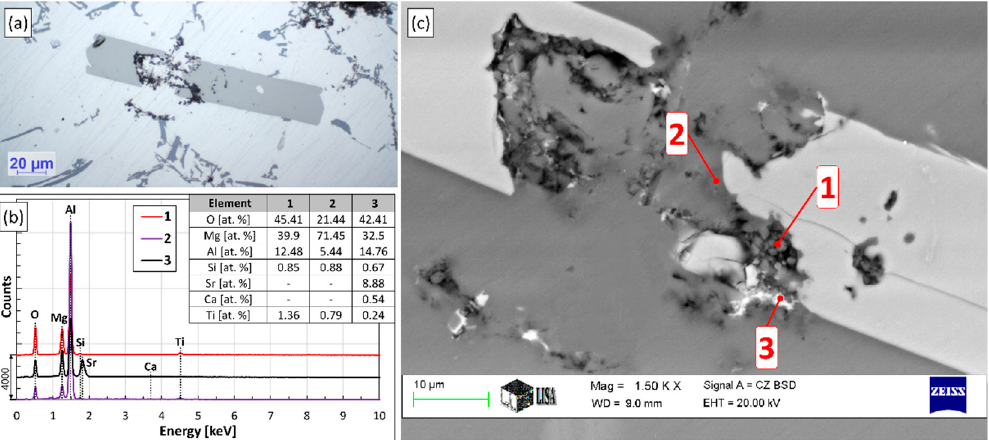
Figure 13. ( a ) Optical micrograph and ( c ) SEM image of an (Al,Si) 3 Ti particle associated with oxide phases, ( b ) the results of the EDS analysis at different points.